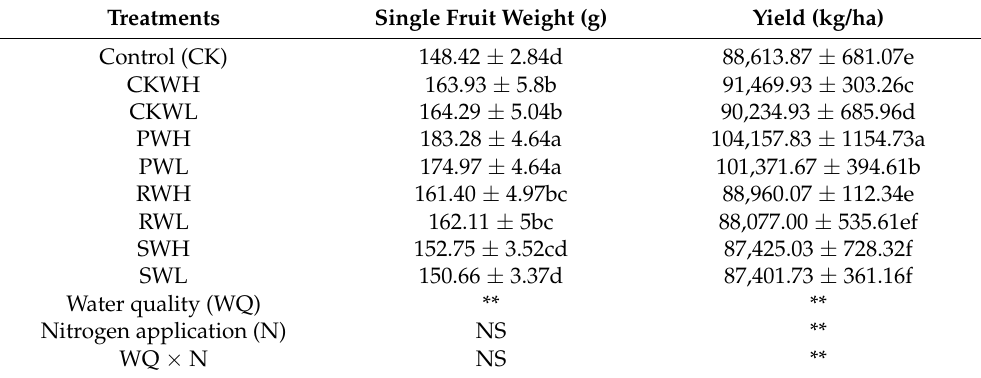
Table 7. Effects of different irrigation treatments on weight per fruit and cucumber yield.